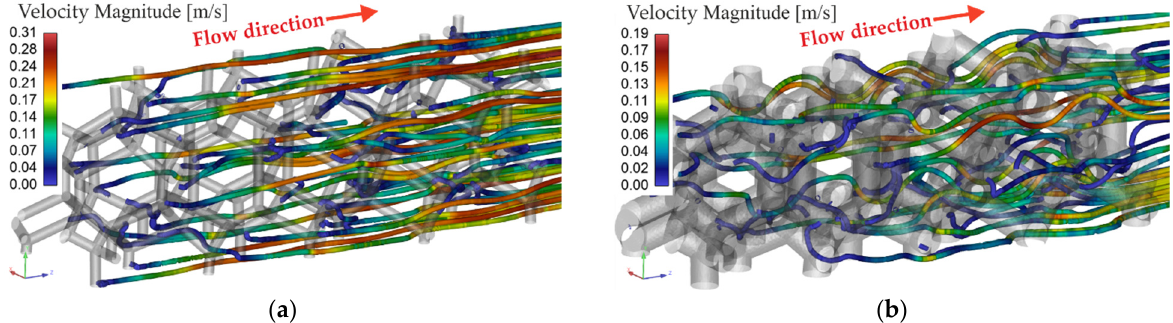
Figure 8. The velocity streamlines for steady flow at Re = 25. Unit is m/s. ( a ) ε = 0.954. ( b ) ε = 0.743.